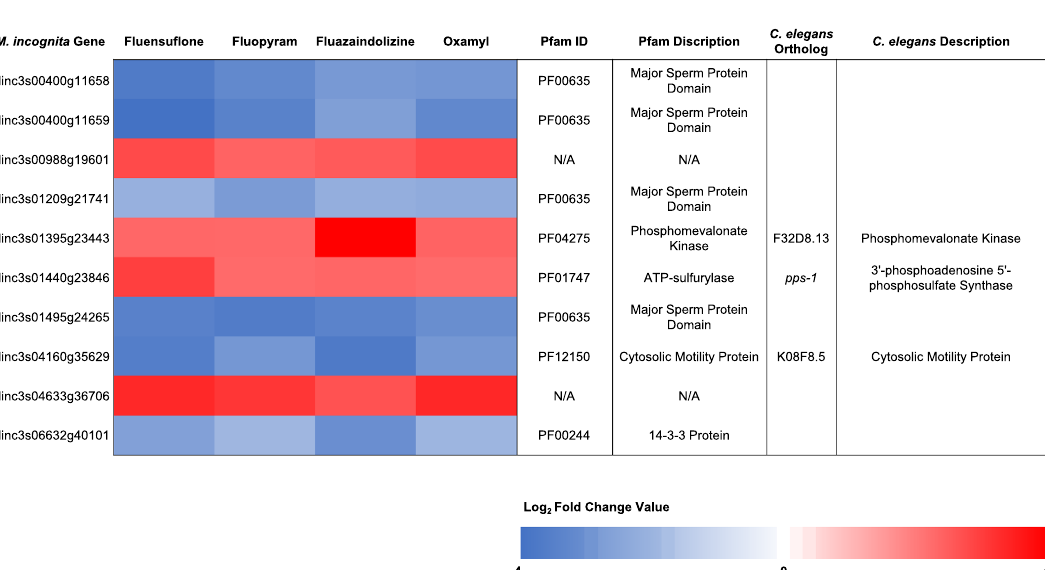
Figure 3. Common differentially expressed genes across treatments. Meloidogyne incognita second-stage juveniles were exposed to fluazaindolizine, fluensulfone, fluopyram, and oxamyl for 24-h and high throughput sequencing used to determine gene expression compared to water control (N = 4 replicates/treatment). The heatmap shows expression of genes that were common to four nematicides with p -adjusted value < 0.05